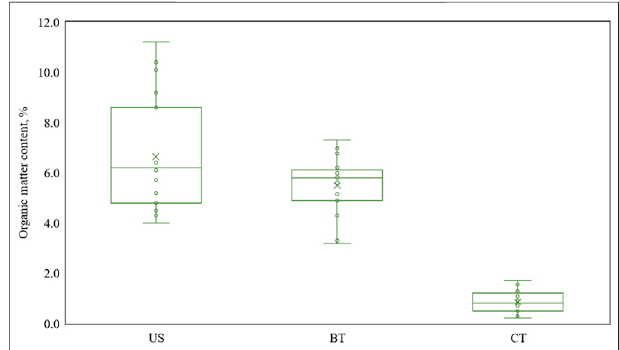
FIGURE 6 | Box and whisker plots of saturated hydraulic conductivity (K sat ) among the disturbed types; undisturbed and shallow disturbance (US), bladed skid trail (BT), and compacted road surface (CT). The circles are data and the line and X are mean value.